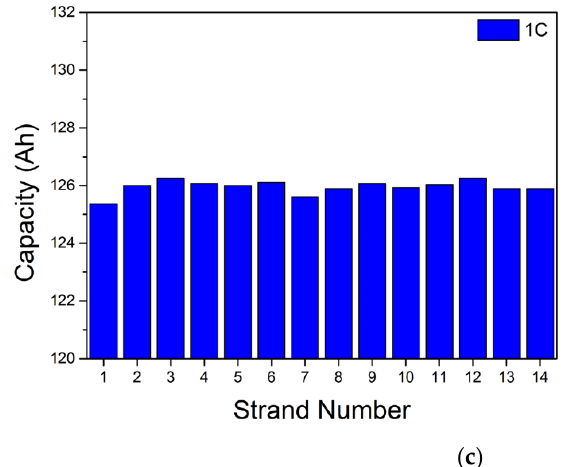
Figure 7. Modeling results of capacity distribution of LIB strands ( a ) 0.2 C, ( b ) 0.5 C, and ( c ) 1 C.